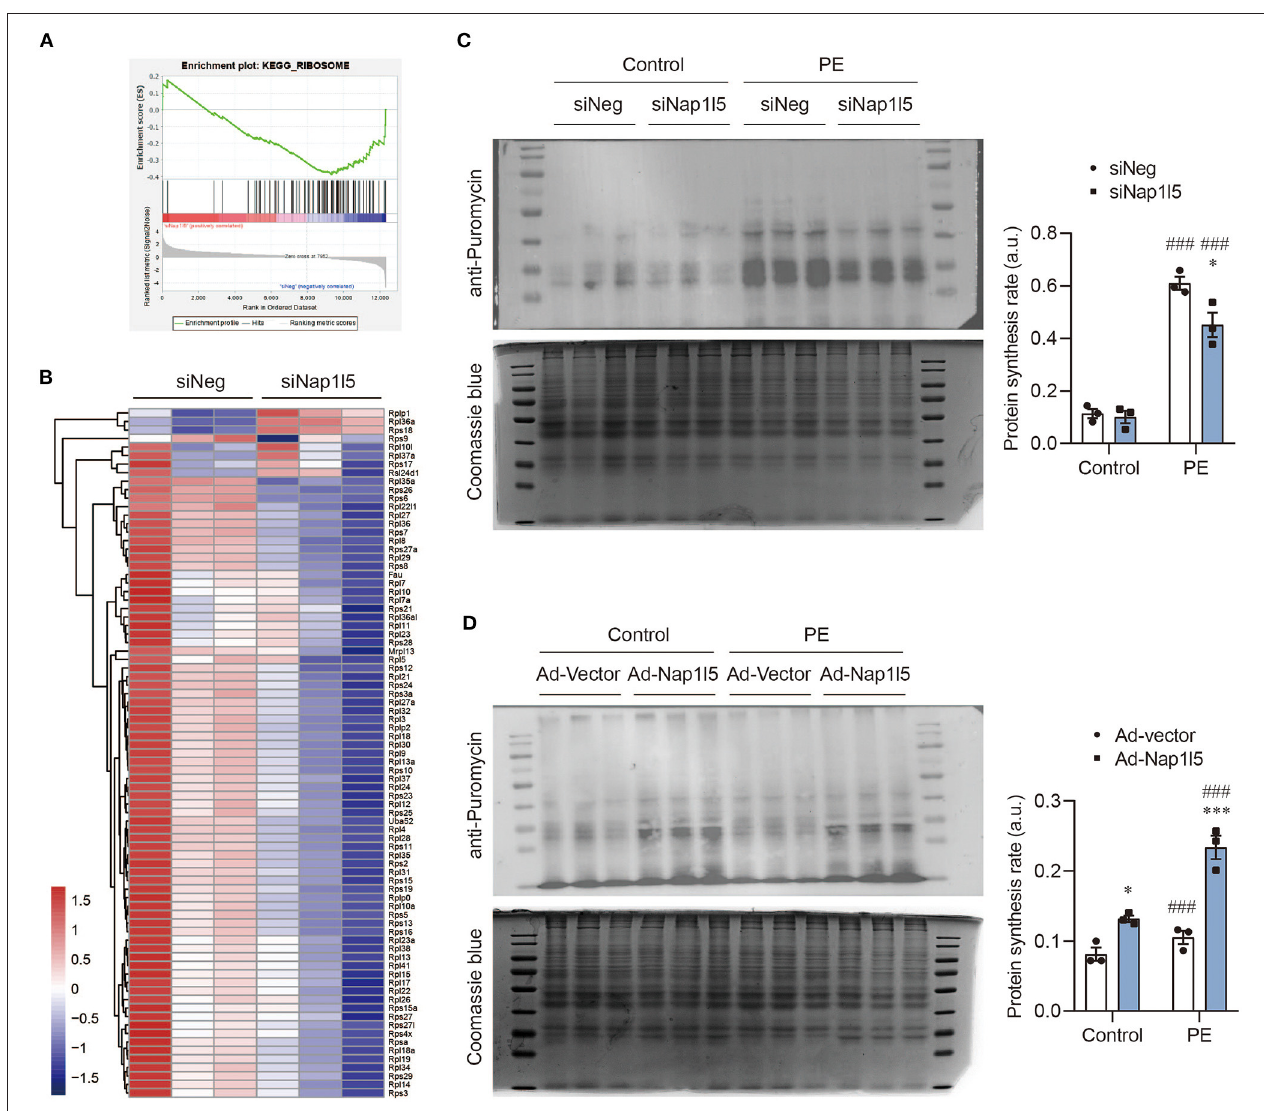
FIGURE 5 | NAP1L5 accelerates protein synthesis rate. (A) GSEA showing the negative enrichment of ribosome-related genes after Nap1l5 knockdown. (B) Heatmap showing the expression of ribosome-related genes after Nap1l5 knockdown. (C) Puromycin incorporation assay showing the protein synthesis rate regulated Nap1l5 knockdown in NRVMs with and without PE treatment. Quantification data were normalized to Coomassie blue staining. * P < 0.05 vs. siNeg; ### P < 0.001 vs. Control. n = 3. (D) Puromycin incorporation assay showing the protein synthesis rate regulated Nap1l5 overexpression in NRVMs with and without PE treatment. * P < 0.05, *** P < 0.001 vs. siNeg; ### P < 0.001 vs. Control. n =